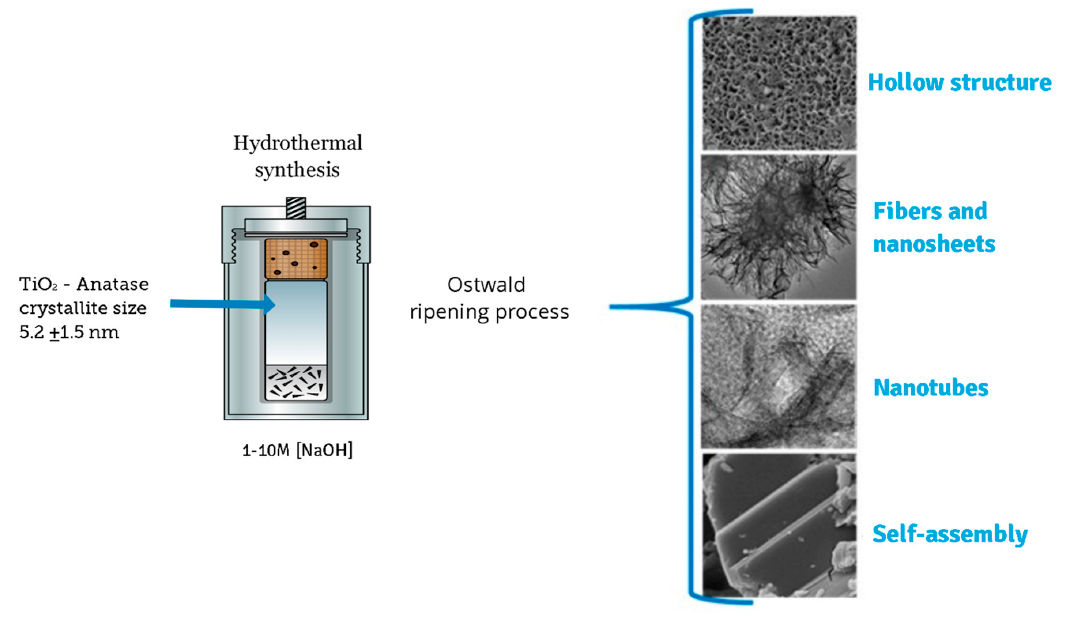
Figure8. Figure 8. Sequential events for the synthesis of the different nanostructures in the given experimental conditions.